Question: Provide a one-line summary of what is displayed.
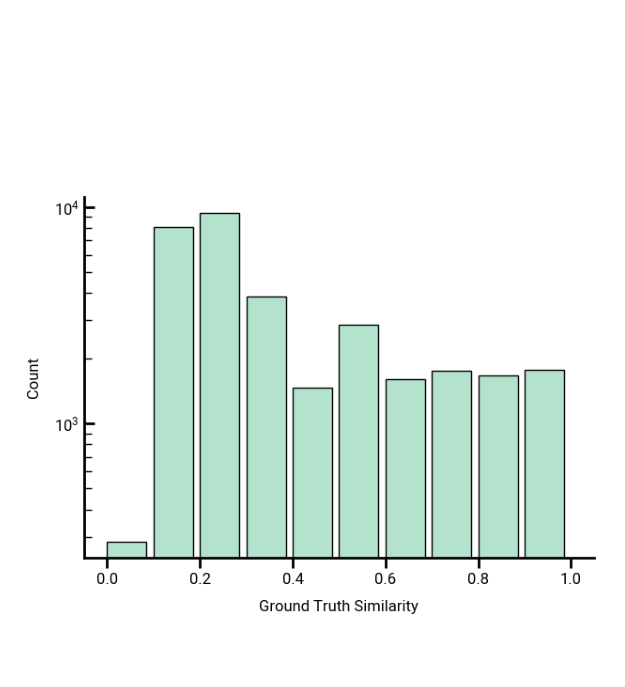
Answer: Distribution of ground truth similarity scores in the HELIX-generated dataset. The dataset was generated such that there would not be an unreasonable abundance of low- similarity or high-similarity scores to avoid benefiting biased similarity metrics.